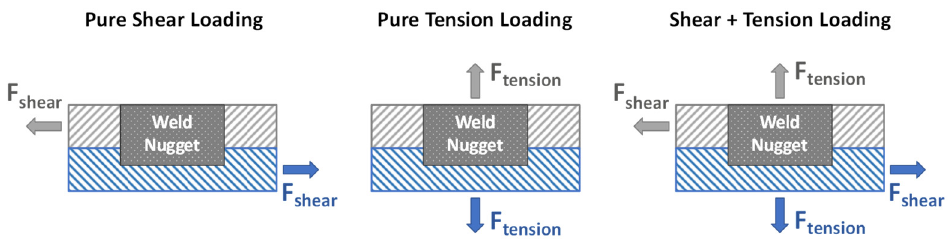
Figure 15. Refill spot weld cross-section schematics with external loading conditions, including pure shear loading, pure tension loading, and shear-and-tension loading.